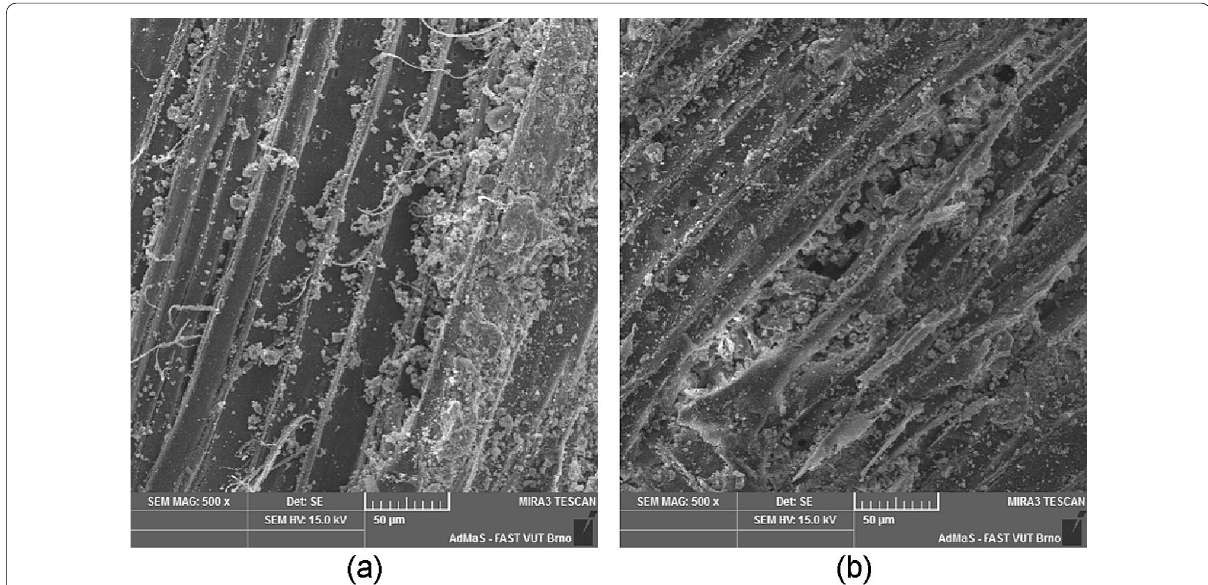
Production of boards - CIDEM Hranice, a.s. Ageing of boards - CIDEM Hranice,